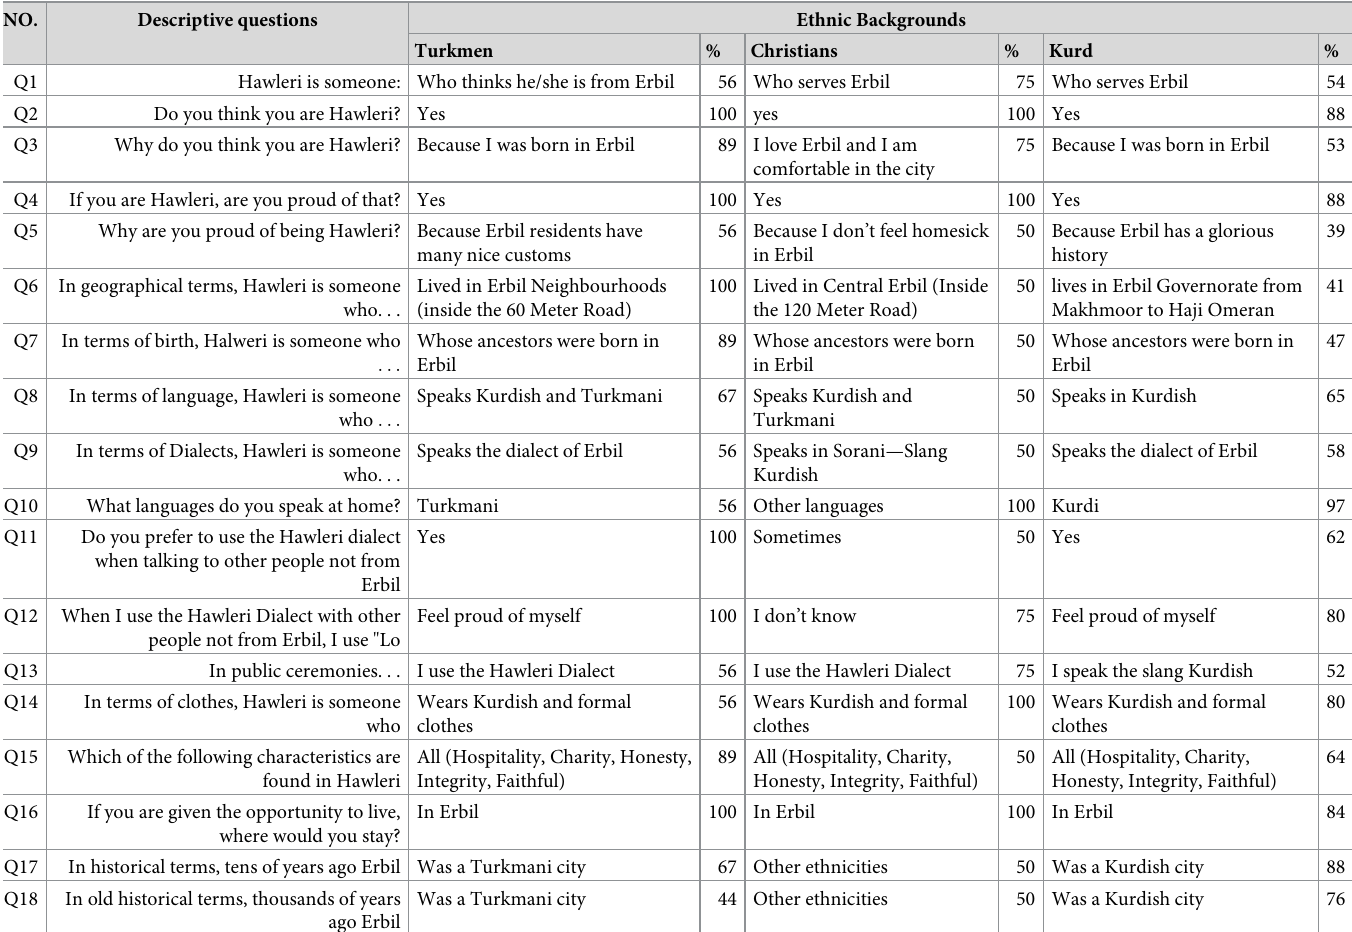
Table 3. Responses of the Descriptive questions based on the ethnic Backgrounds (Kurd, Turkmen and Christians).